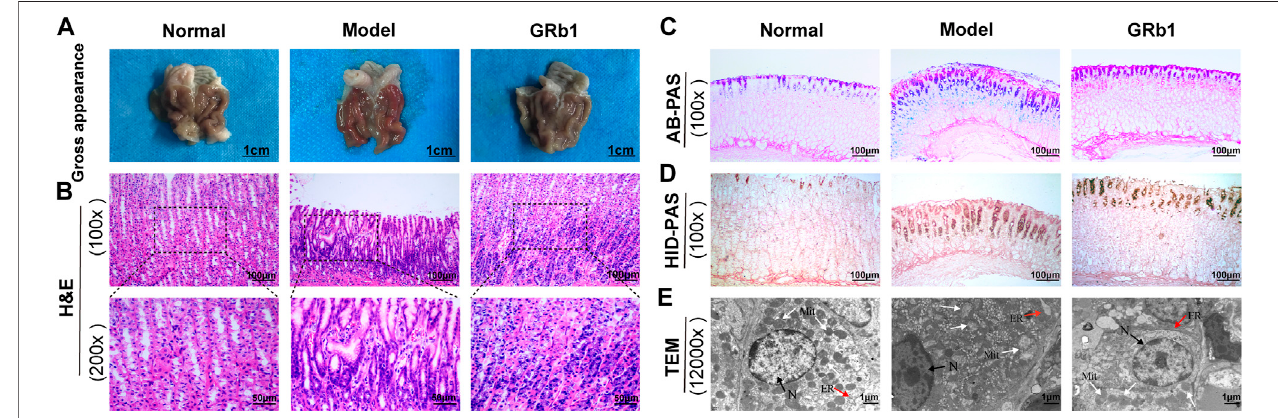
FIGURE 2 | Effects of GRb1 on pathomorphology of dysplasia and on gastric intestinal metaplasia in GPL model rats. (A) Gross evaluation of the gastric mucosa. (B) Microscopic appearance of the gastric epithelium using hematoxylin and eosin staining (magni fi cation × 100, × 200). (C) Evaluation for intestinal metaplasia lesion using alcian blue-periodic acid schiff staining (magni fi cation × 100). (D) Assessment for colonic-type metaplasia using high iron diamine-periodic acid schiff staining (magni fi cation × 100). (E) Representative images indicating the ultrastructures of epithelial cells using transmission electron microscope (TEM) (magni fi cation × 12,000). Abbreviations: GRb1, ginsenoside Rb1; GPL, gastric precancerous lesions. N, nucleus (black arrow); Mit, mitochondrion (white arrow); ER, endoplasmic reticulum (red